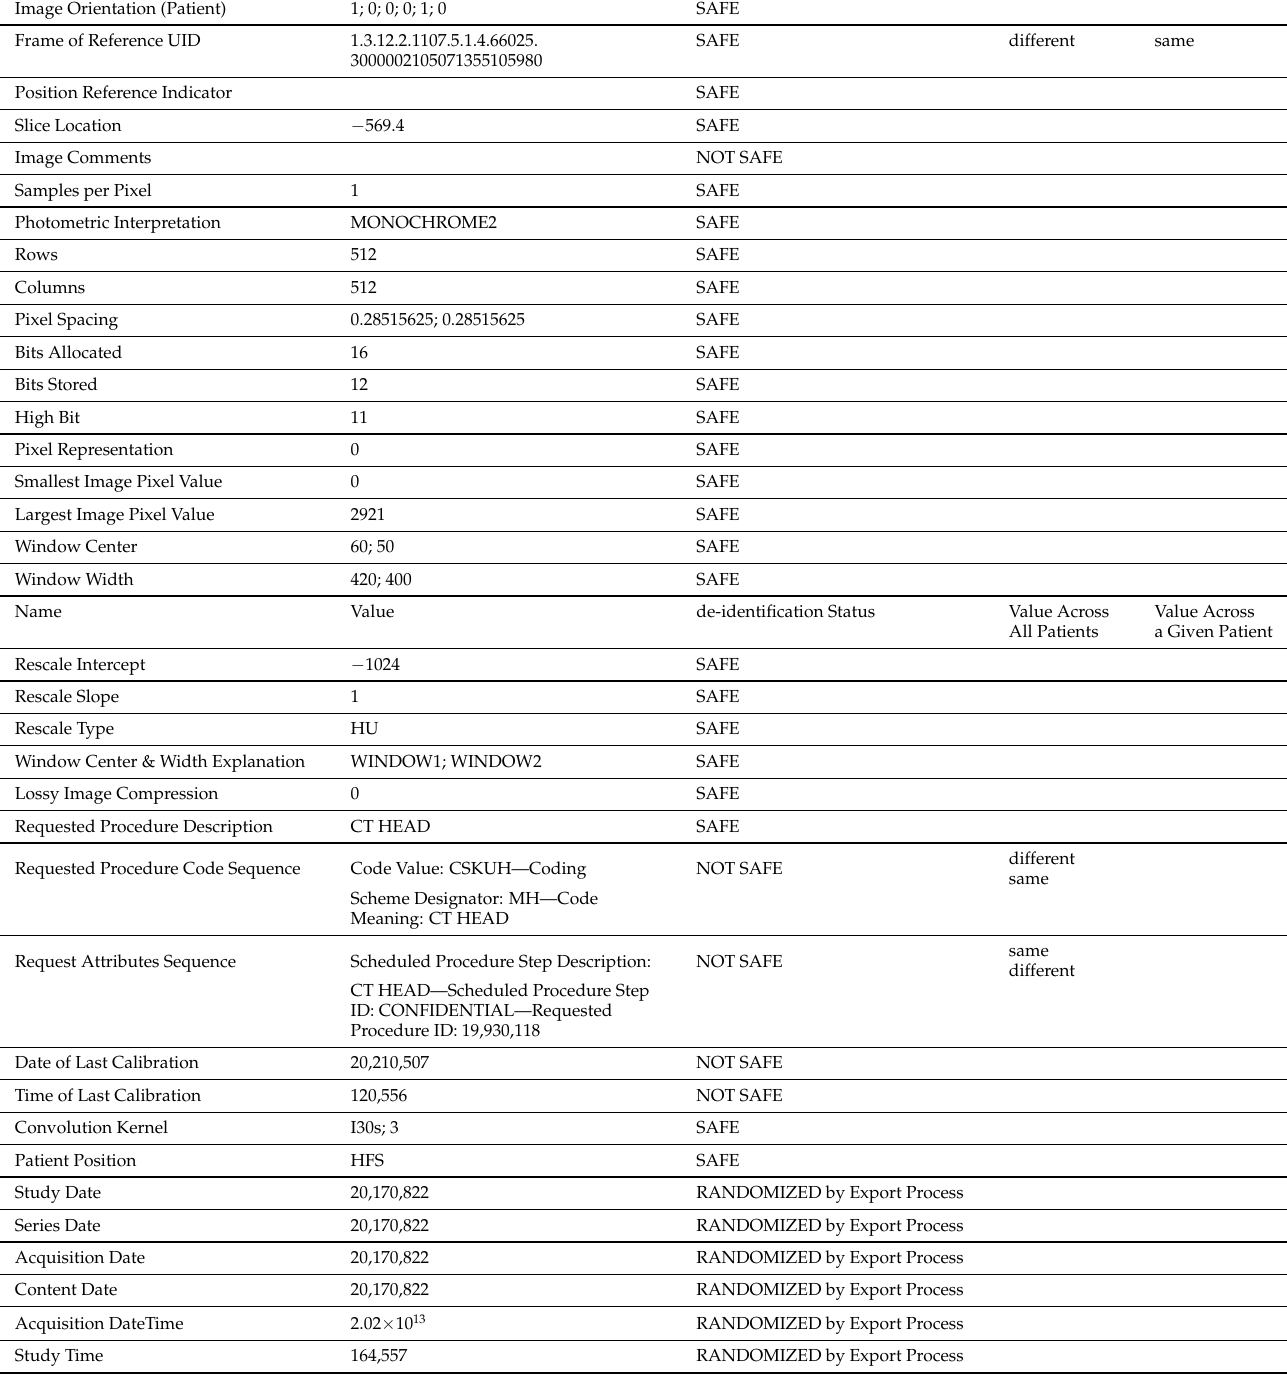
Table A3. Detailed examination of DICOM header (part